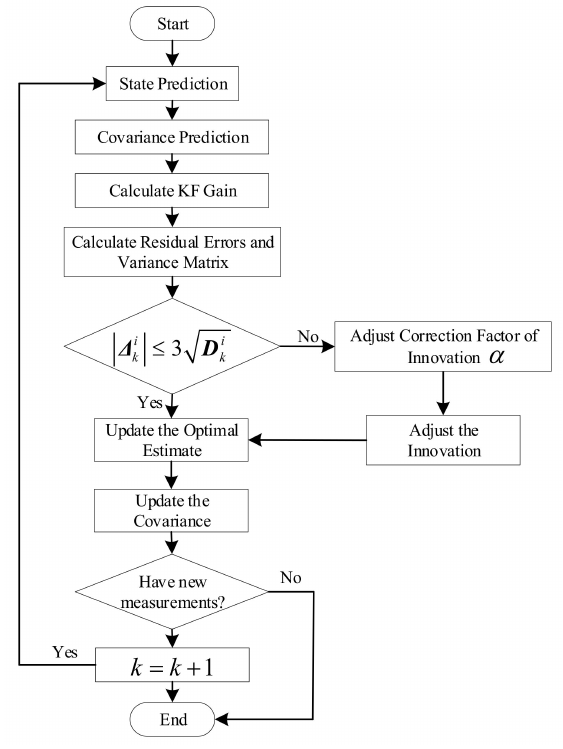
Figure 3. Flow chart of the adaptive anti-NLOS KF algorithm.